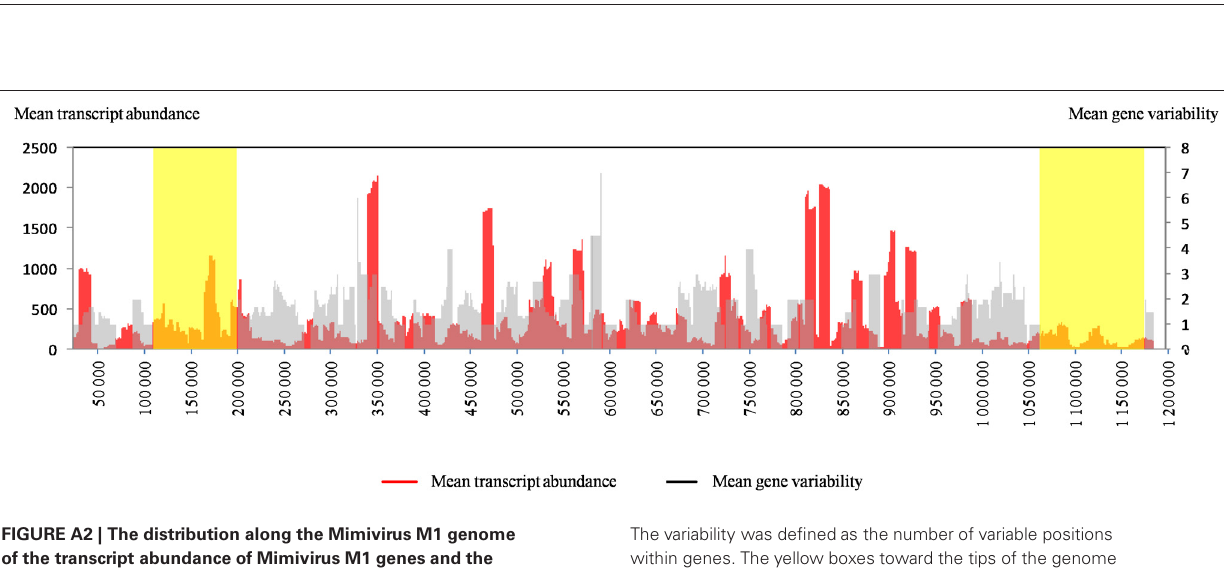
FIGURE A2 | The distribution along the Mimivirus M1 genome of the transcript abundance of Mimivirus M1 genes and the nucleotide variability for the same genes in Mimivirus M1 and M4. For both parameters, the mean values for a sliding window of 10 genes and a step of 1 gene are represented.